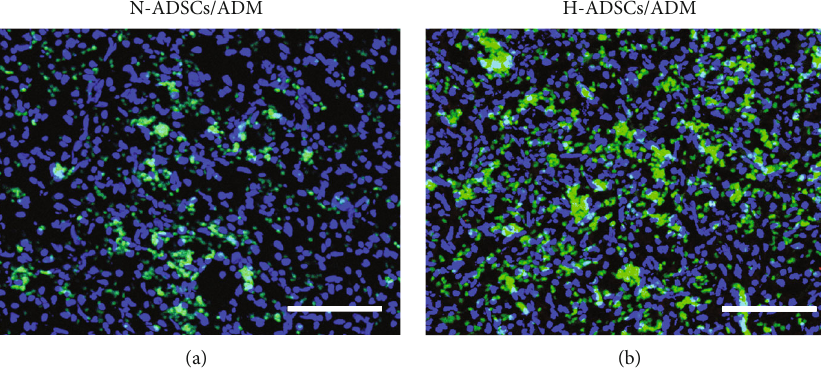
Figure 6: Hypoxia-precondition enhances the survival ability of ADSCs at DFU healing site. ADSC tracing in vivo at postoperative day 14. (a) Skin wound treated with N-ADSCs/ADM membrane with DiO labeling. (b) Skin wound treated with H-ADSCs/ADM membrane with DiO labeling. Bar = 100